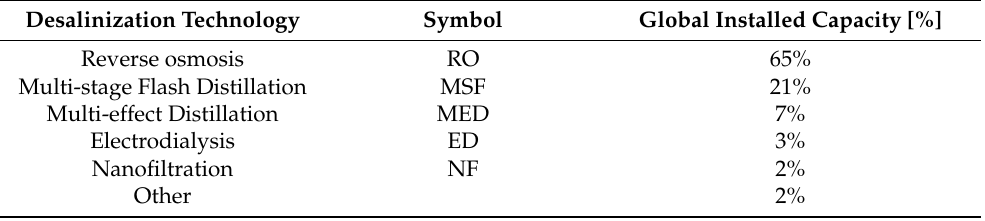
Table 13. Total worldwide installed desalination capacity by technology in 2014: after the data of the International Desalination Association, IDA desalination yearbook 2014–2015, Oxford, U.K.; Media Analytics Ltd., 2015